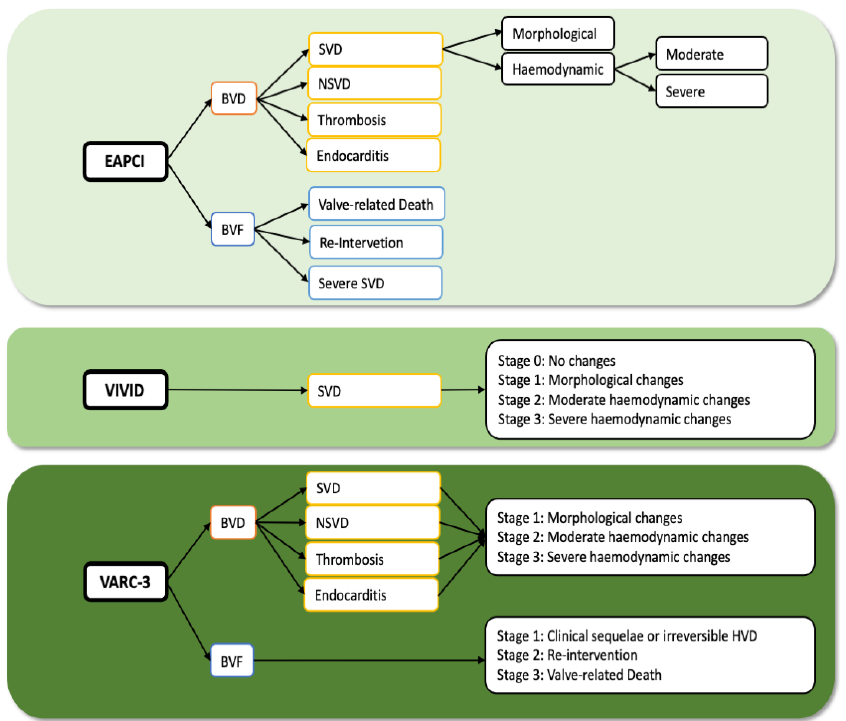
Figure 1. Simplified illustration of current definitions on durability of transcatheter heart valves. EAPCI, European Association of Percutaneous Cardiovascular Interventions; BVD, bioprosthetic valve dysfunction; BVF, bioprosthetic valve failure; SVD, structural valve deterioration; NSVD, non-structural valve deterioration; VIVID, Valve in Valve International; VARC-3, Valve Academic Research Consortium 3; HVD, hemodynamic valve deterioration.